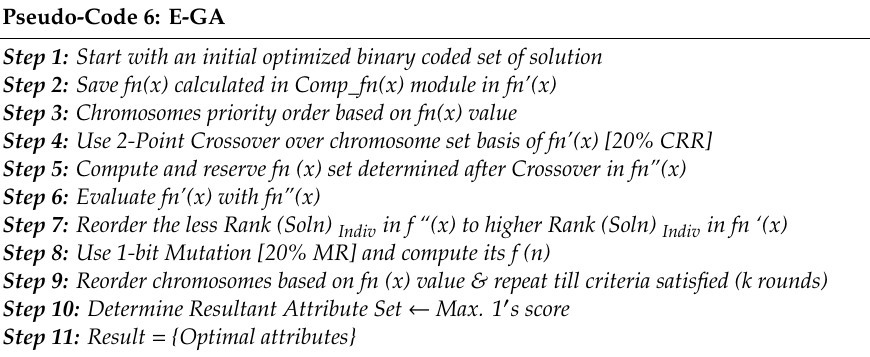
Table 9. Pseudo-code 6 for Enhanced Genetic Algorithm (E-GA) [47].